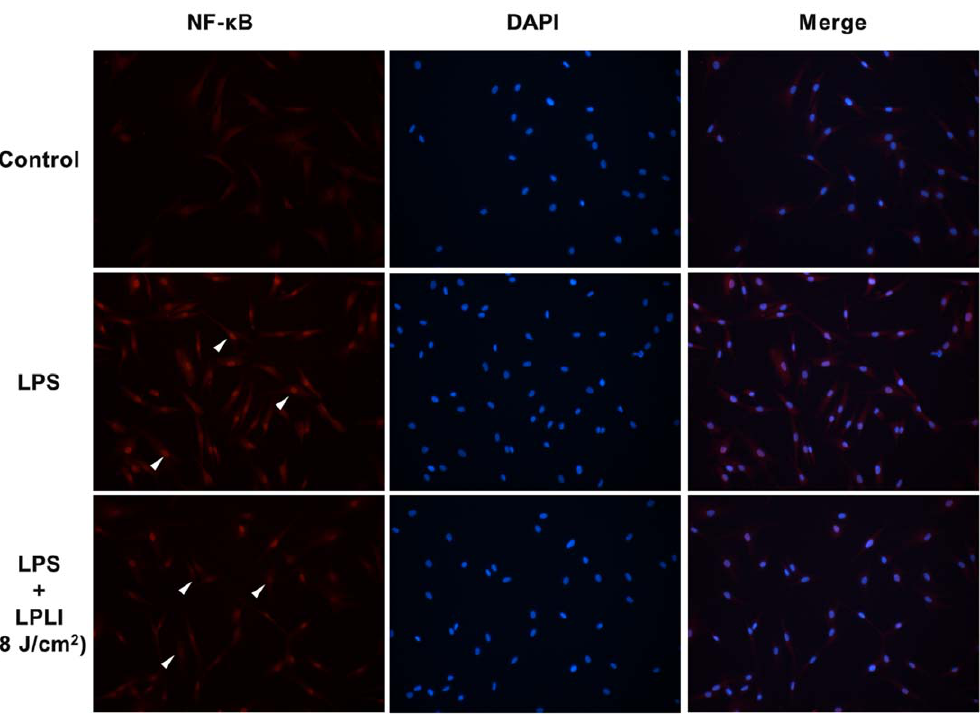
Figure 5. LPLI decrease nuclear translocation of NF- k B. hADSCs were pre-treated with or without LPS (50 ng/ml), followed by LPLI (8 J/cm 2 ), and the localization of the NF- k B was determined by fluorescence. The images in the upper panel show the cytoplasmic localization of NF- k B in the control cells. The image in the middle panel shows the nuclear translocation of NF- k B in cells treated with LPS. The image in the lower panel shows that LPLI treatment blocked the nuclear translocation of NF- k B caused by LPS stimulation.